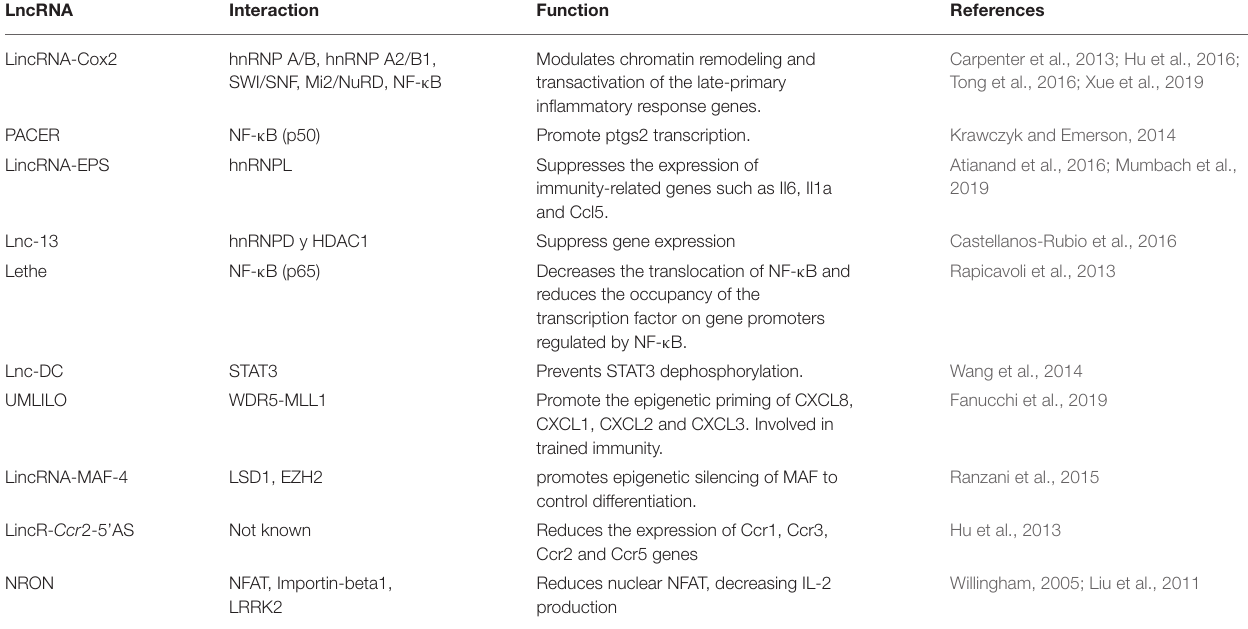
TABLE 1 | Functions of some LncRNAs related to the modulation of gene expression associated with the immune response.